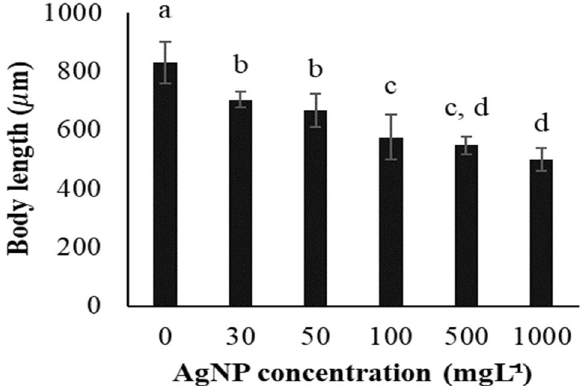
Figure 6. Effect of AgNP concentration on body length of Artemia nauplii incubated on tryptic soy agar for 48 h. Values are presented as means ± S.D. (n = 10). The same letters indicate statistically insignificant differences ( p > 0.05).